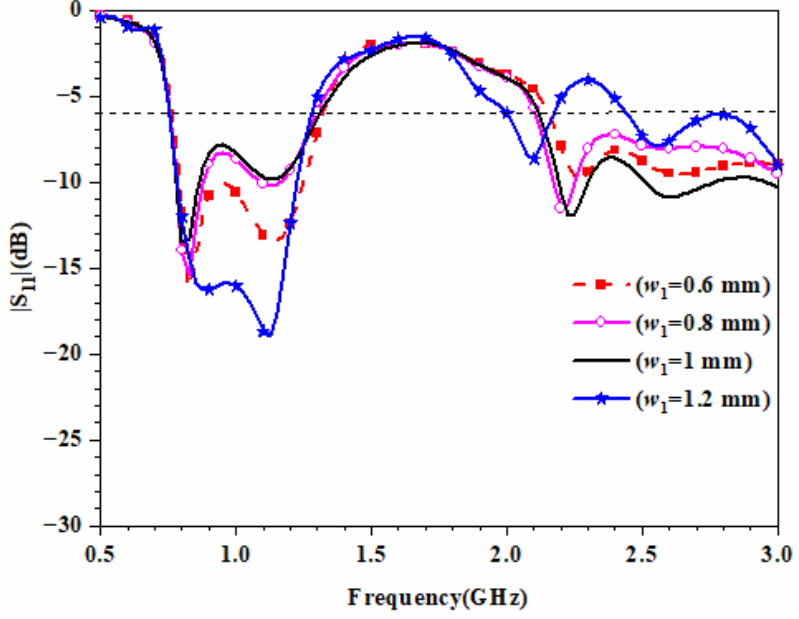
Figure 3. Influence of w 1 on |S 11 |.